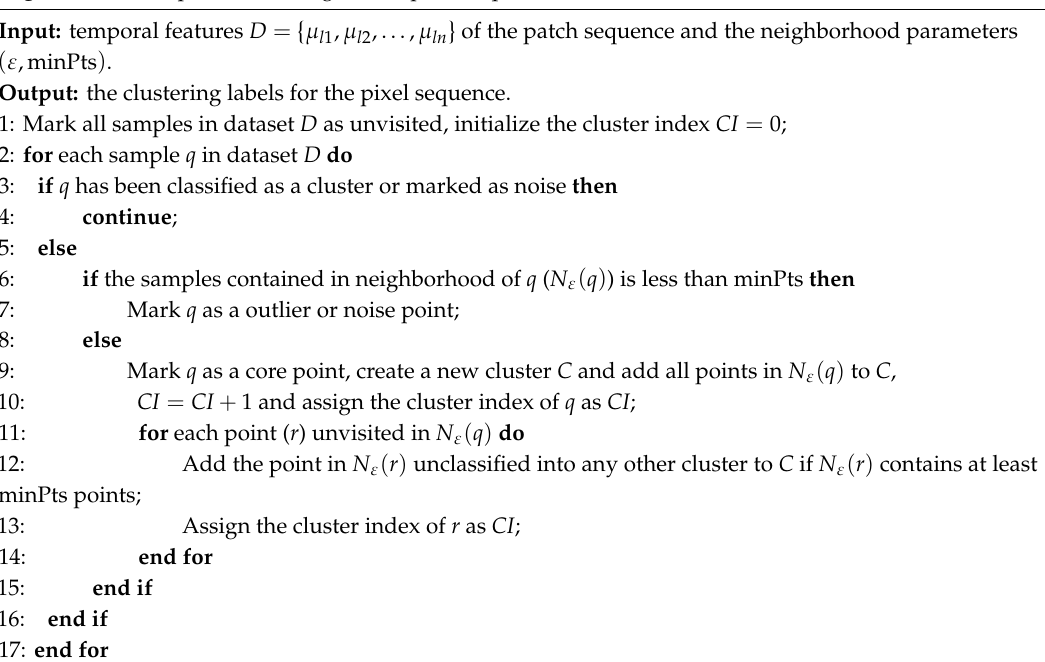
Algorithm 1. Temporal clustering for the pixel sequence (DBSCAN).